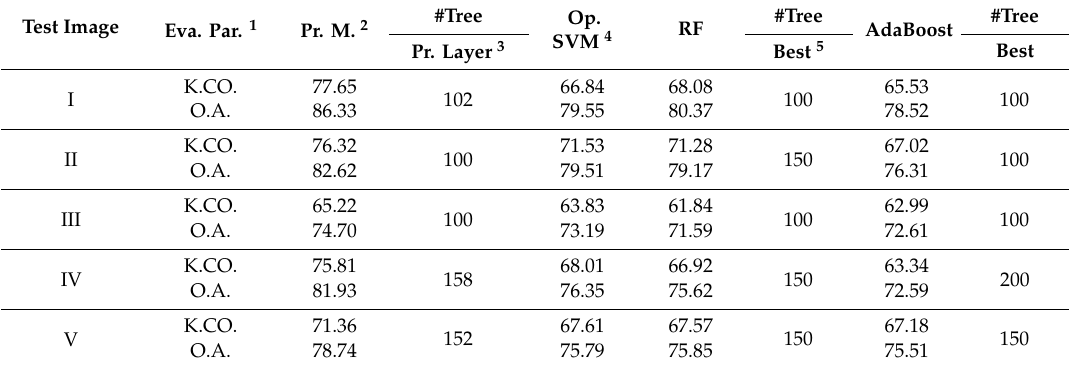
Table 4. Results of the implementation of comparative methods in terms of the classification